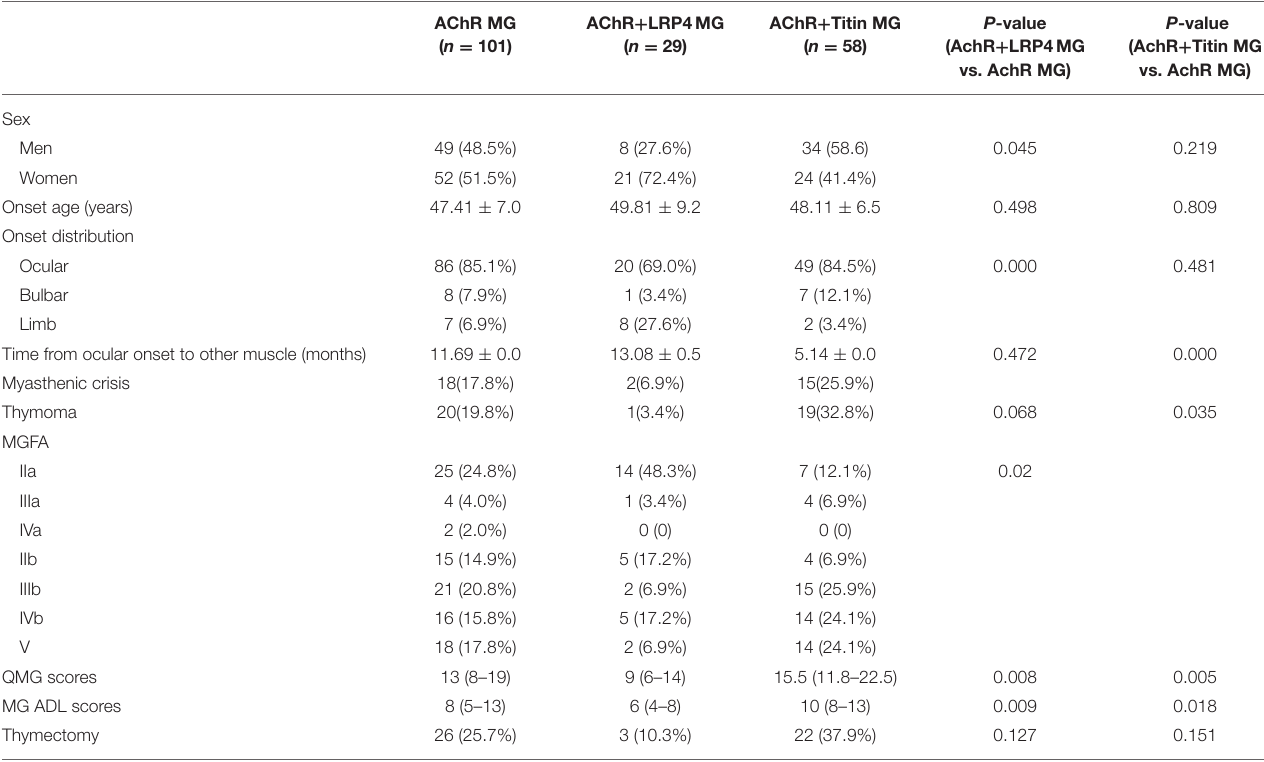
TABLE 1 | Characteristics of patients with AChR-MG, AChR + LRP4-MG and AChR +